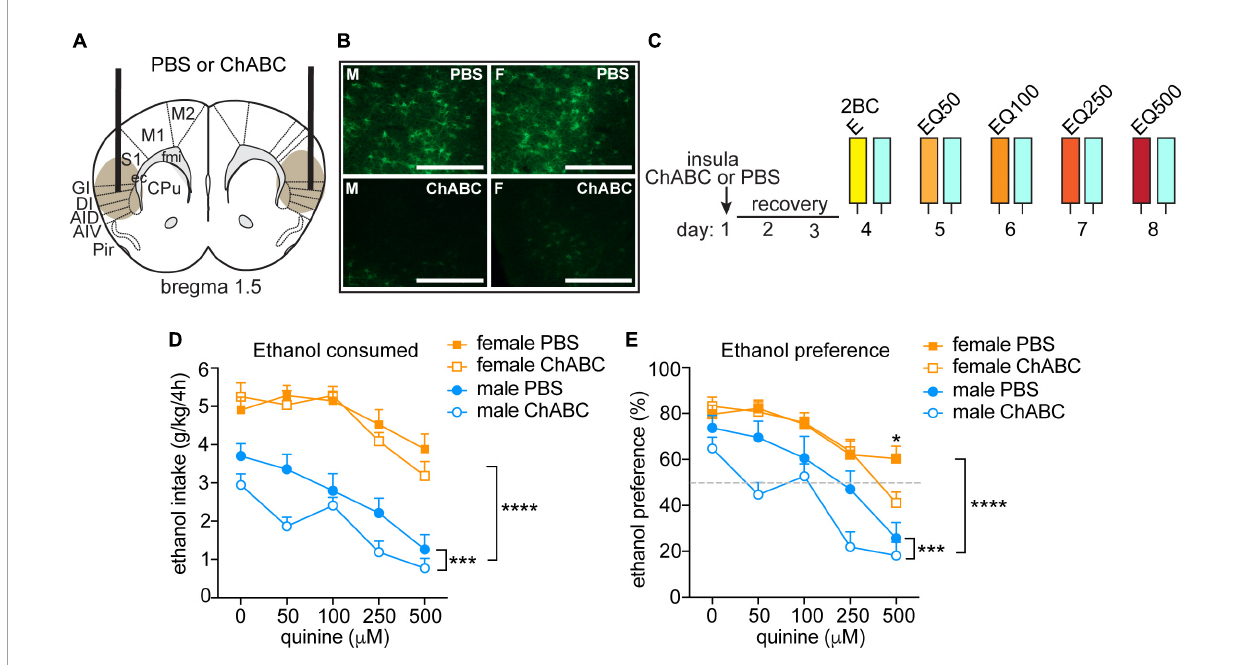
FIGURE3 Disrupting PNNs only in male mice increases sensitivity to quinine-adulterated ethanol. (A) Illustration of mouse brain coronal section indicating sites of chondroitinase ABC (ChABC) or PBS injection into the anterior insula. Brown oval shows approximate spread of ChABC, as determined by reduced fluorescent WFA staining. (B) Representative images of fluorescent WFA staining in male (M, left panels) and female (F, right panel) mice 3 days after PBS (top panels) or ChABC injections into the insula. Scale bar, 200 µ m. (C) Experimental design. Mice were injected with ChABC ( n = 16 males and 16 females) or PBS ( n = 16 males and 16 females) in the insula and recovered from surgery for 3 days, followed by two-bottle choice (2BC) ethanol drinking in the dark. Quinine was added in increasing concentrations from 50 to 500 µ M each day to the ethanol (EQ50, EQ100, EQ250, and EQ500). (D) Daily ethanol consumed in g per kg body weight in 4 h. (E) Daily ethanol preference, expressed as ethanol consumed divided by total fluid consumed × 100. **** P < 0.0001, main effect of sex by three-way ANOVA; *** P < 0.001, main effect of ChABC in males by two-way ANOVA; * P < 0.05, PBS vs. ChABC in females at 500 µ M quinine.